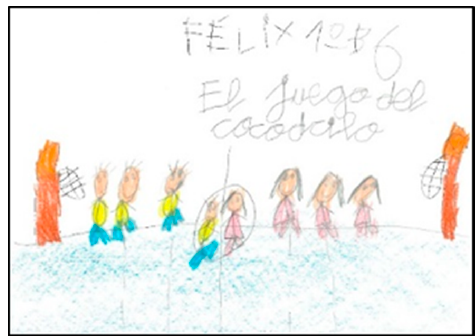
Table 3. Games and sports represented by children.